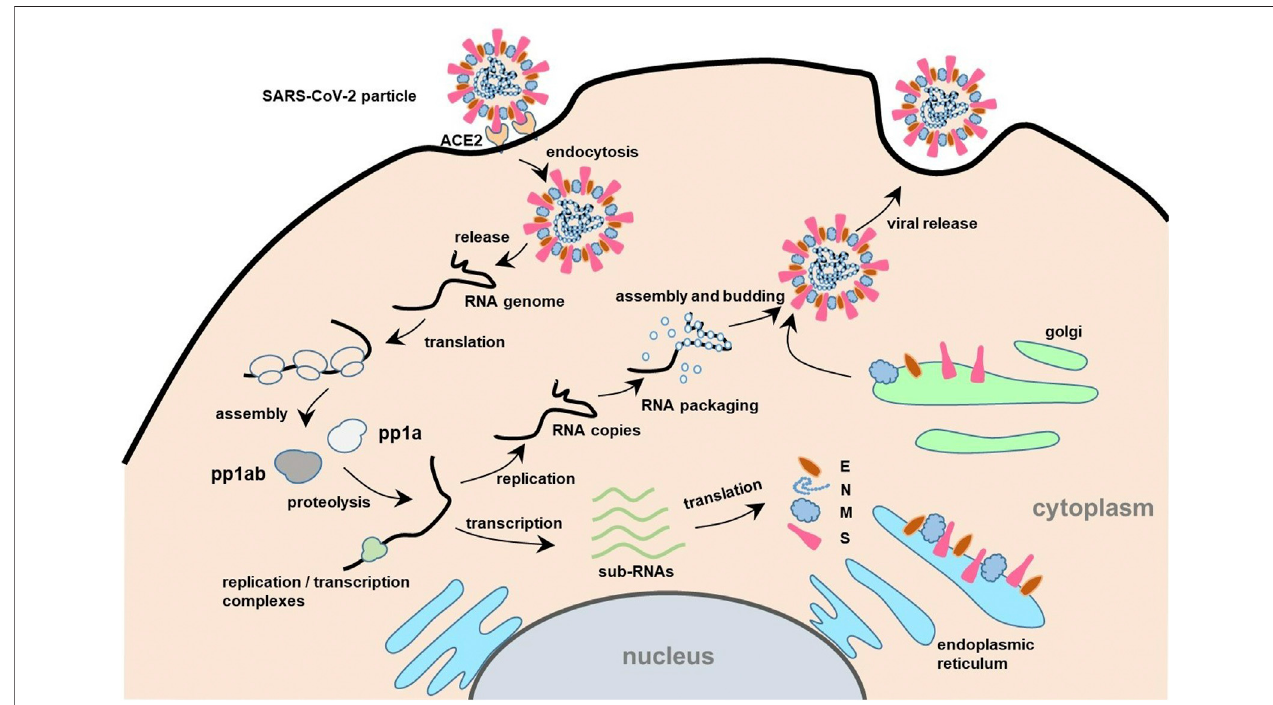
FIGURE2| SchematicillustrationoftheprocessofSARS-CoV-2infectingthehostanditslifecycle.Thereceptorbindingdomain(RBD)ofSproteinofSARS-CoV- 2 mediates the infection by binding to angiotensin-converting enzyme 2 (ACE2) receptors on the surface of host cells (Inoue et al., 2007). The virus enters the cell by endocytosis, and then releases the RNA genome. Subsequently, the speci fi c sequence translate polyprotein (pp)1a/1ab are translated to the polyprotein pp1a and pp1ab, respectively. Pp1a and pp1ab are self-cleaved into 16 nonstructural proteins (nsps) by proteolysis (Ji et al., 2020). The nsps coalesce to form replicase/ transcriptase complexes containing multiple enzymes. Within the complexes, the offspring RNA is transcribed, which is used as sub-RNA to translate the structural proteins (E, N, M, S) and some auxiliary proteins of the virus (Kim D. et al., 2020). Then, the structural proteins enter the Golgi intermediate region of the endoplasmic reticulumalongthesecretorypathwaytocompleteself-assembly.Meanwhile,thereplicatedRNAcopiesbindtoNproteintoformaribonucleoproteincomplex.Through the intake of ribonucleoprotein complex by the viral vesicles, the matured viruses are formed and then released outside the